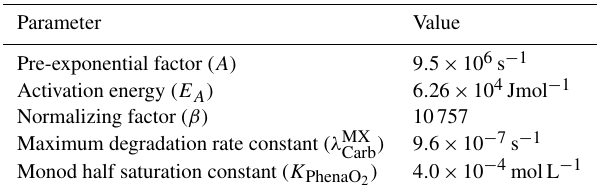
Table 2. Parameters used to simulate the dynamics of